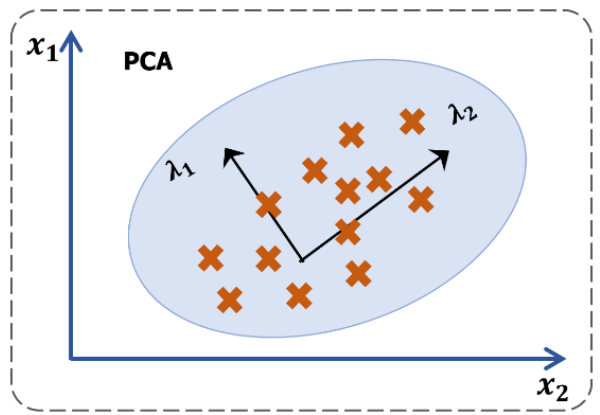
Figure 4. The architecture of principal component analysis.